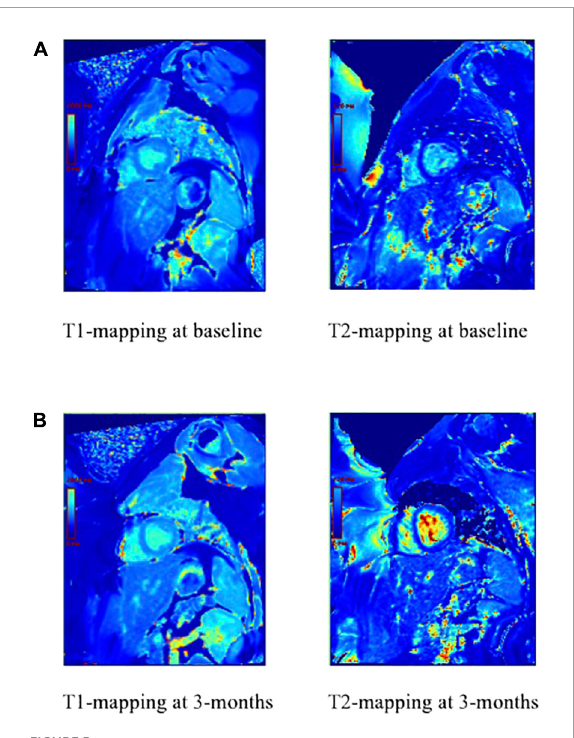
FIGURE5 T1 and T2-mapping of the myocardium prior to anthracycline-based chemotherapy (A) and 3 months after anthracycline-based chemotherapy (B) . T1 has changed, which indicates active injury or ongoing fibrosis. T2 has also changed, which indicates increased water and active inflammation of the